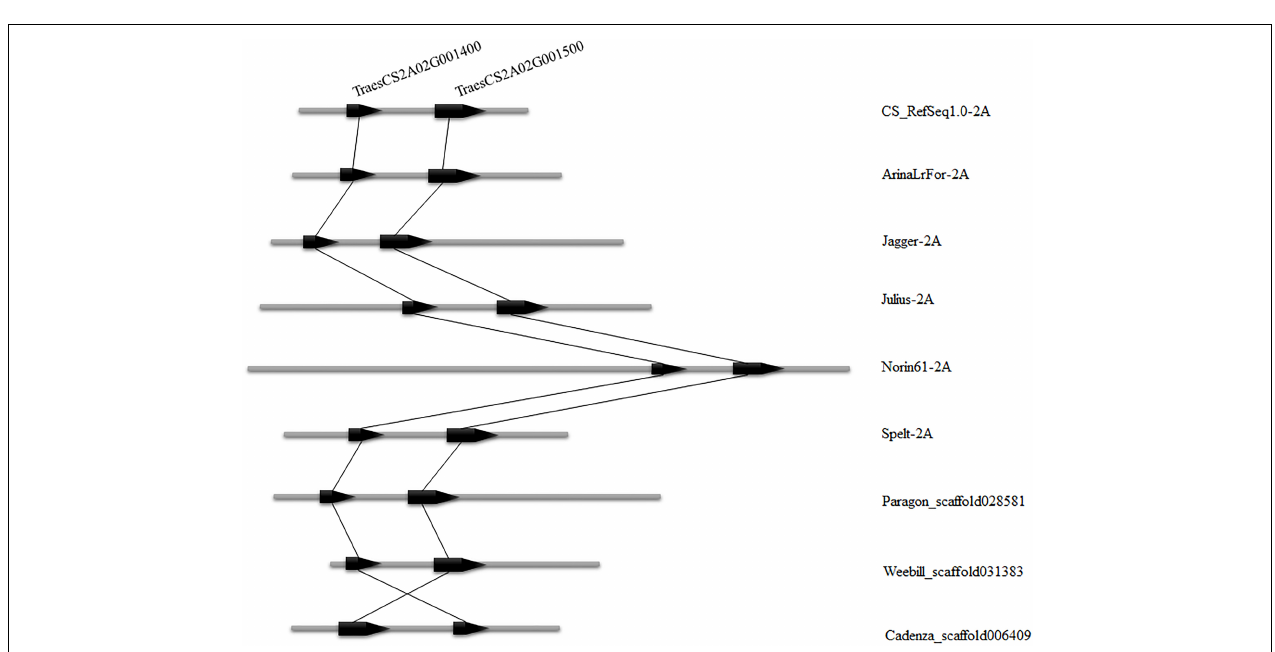
FIGURE 5 | Candidate interval of two genes TraesCS2A02G001400 and TraesCS2A02G001500 compared among nine wheat varieties. The left side indicates the position of the gene on the chromosome and the right side is the wheat variety name.